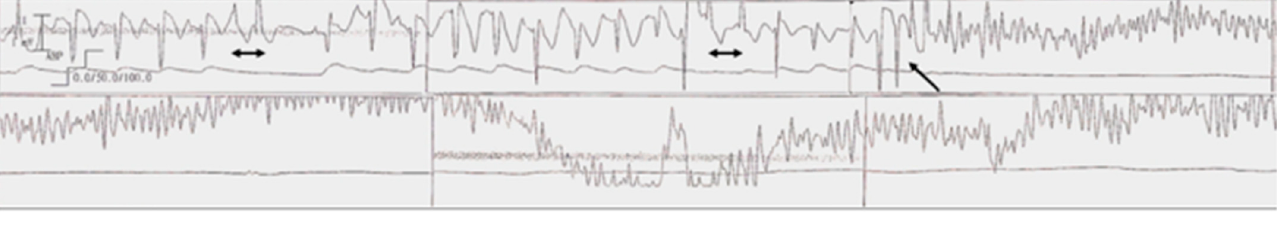
Figure 2. ECG rhythm strip on fourth postnatal day showing two PVC couplets (double arrow), followed by an R-on-T event (arrow) that initiated the TdP.